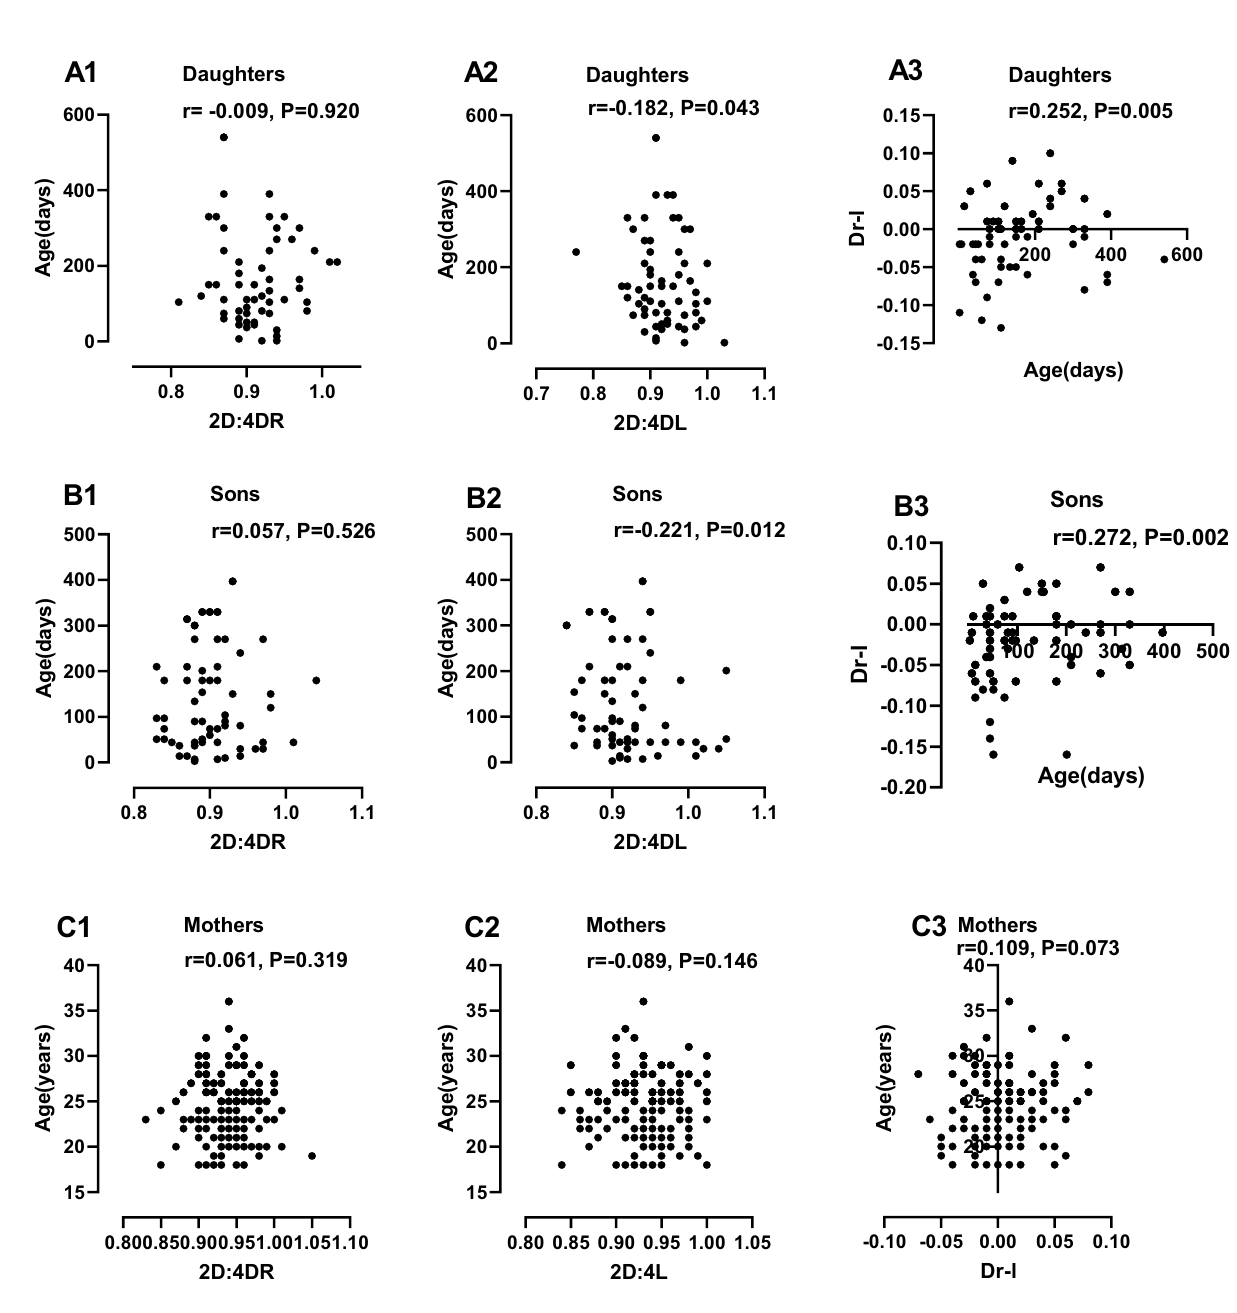
Figure 2. Pearson correlation scatterplots between age and digit ratios: correlation between digit ratios and age among daughters ( A1 = 2D:4DR, A2 = 2D:4DL, A3 = Dr-l), correlation between digit ratios and age among sons ( B1 = 2D:4DR, B2 = 2D:4DL, B3 = Dr-l), correlation between digit ratios and age among mothers ( C1 = 2D:4DR, C2 = 2D:4DL, C3 =